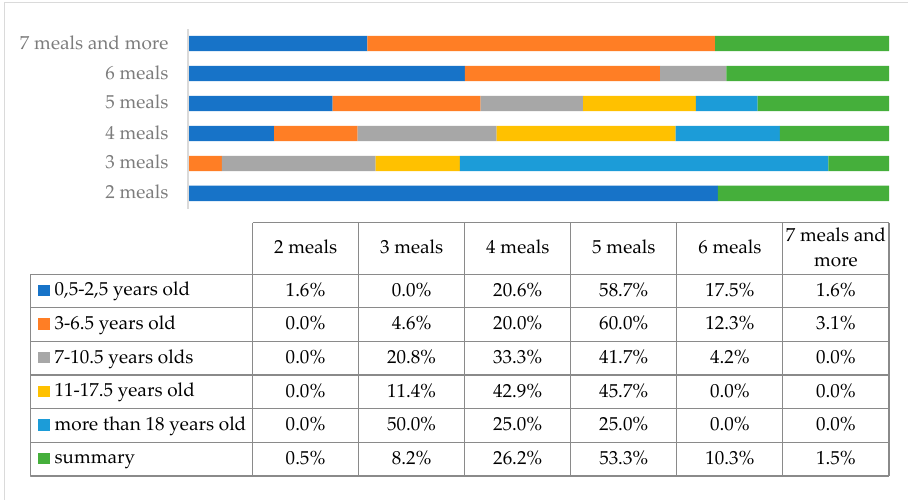
Figure 8. A number of meals consumed per day in the study group of individuals with DS by age.